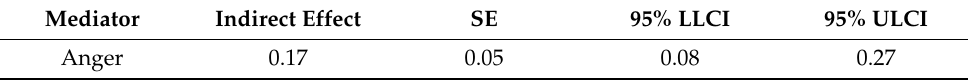
Table 5. Results of indirect and conditional indirect effect analyses.